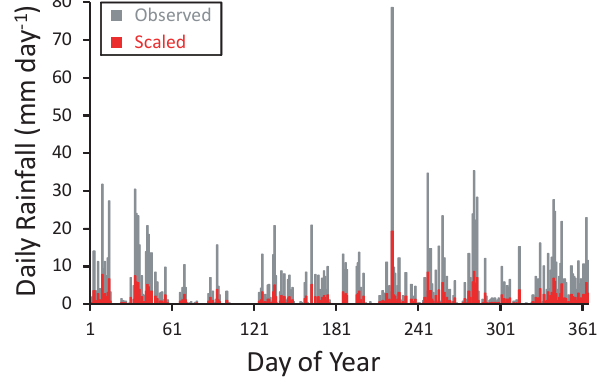
Figure 4. 365-day time series of daily observed rainfall, and its conversion to net rainfall, U , after scaling by a factor of 0.245. See main text for full